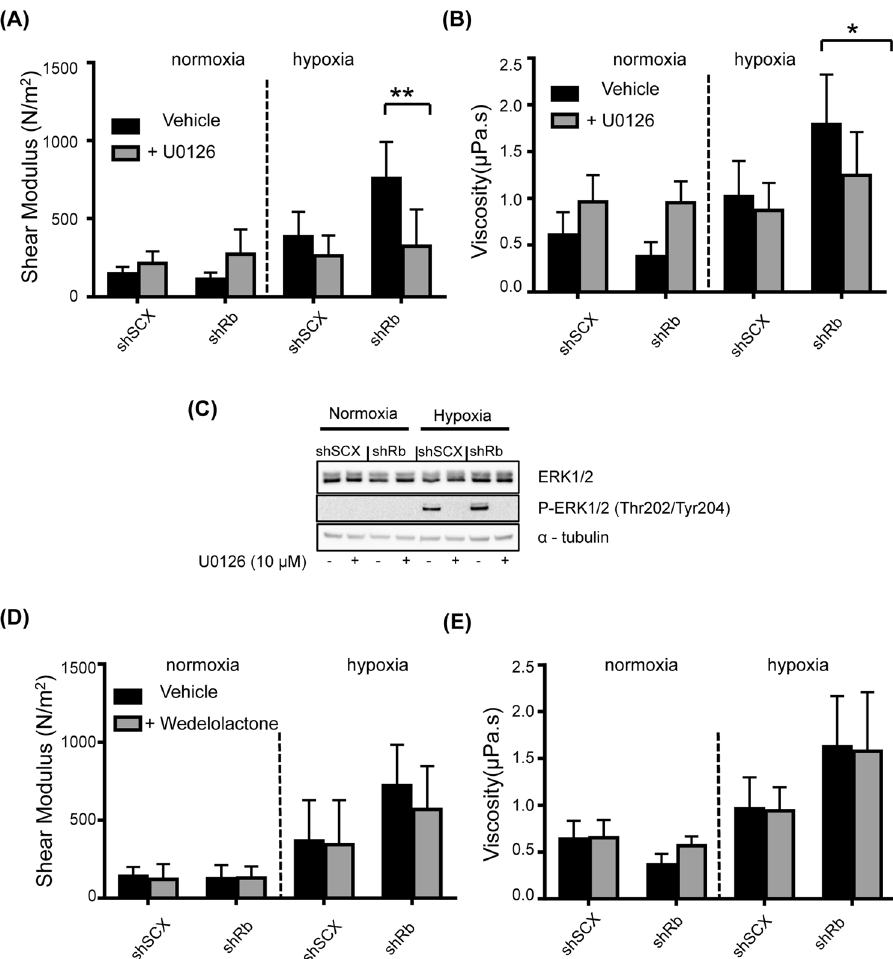
Figure 3. Inhibiting the MEK1/2-ERK pathway but not the NF κ B pathway alters the mechanical properties of LNCaP cells. Variation in ( A ) shear modulus or ( B ) viscosity of shRb and shSCX LNCaP cells after exposure to 72 h of hypoxia or normoxia and treated with or without 10 μ M U0126. ( C ) Immunoblots of LNCaP shRb and shSCX whole cell lysates after exposure to 72 h of hypoxia or normoxia and treated with or without 10 μ M U0126. Blots were probed with antibodies against ERK1/2, phospho-ERK1/2 (Thr202/Tyr204) and α -tubulin. Samples were derived from the same experiment and blots were processed in parallel. Complete blot images are shown in Supplementary Information File 1, Figure S1. Variation in ( D ) shear modulus or ( E ) viscosity of shRb and shSCX LNCaP cells after exposure to 72 h of hypoxia or normoxia and treated with or without 15 μ M wedelolactone. For A , B , D and E , experiments were conducted in triplicate (n = 3) and ten cells were examined in each experiment. Error bars represent ± S.D. * p < 0.05. ** p <